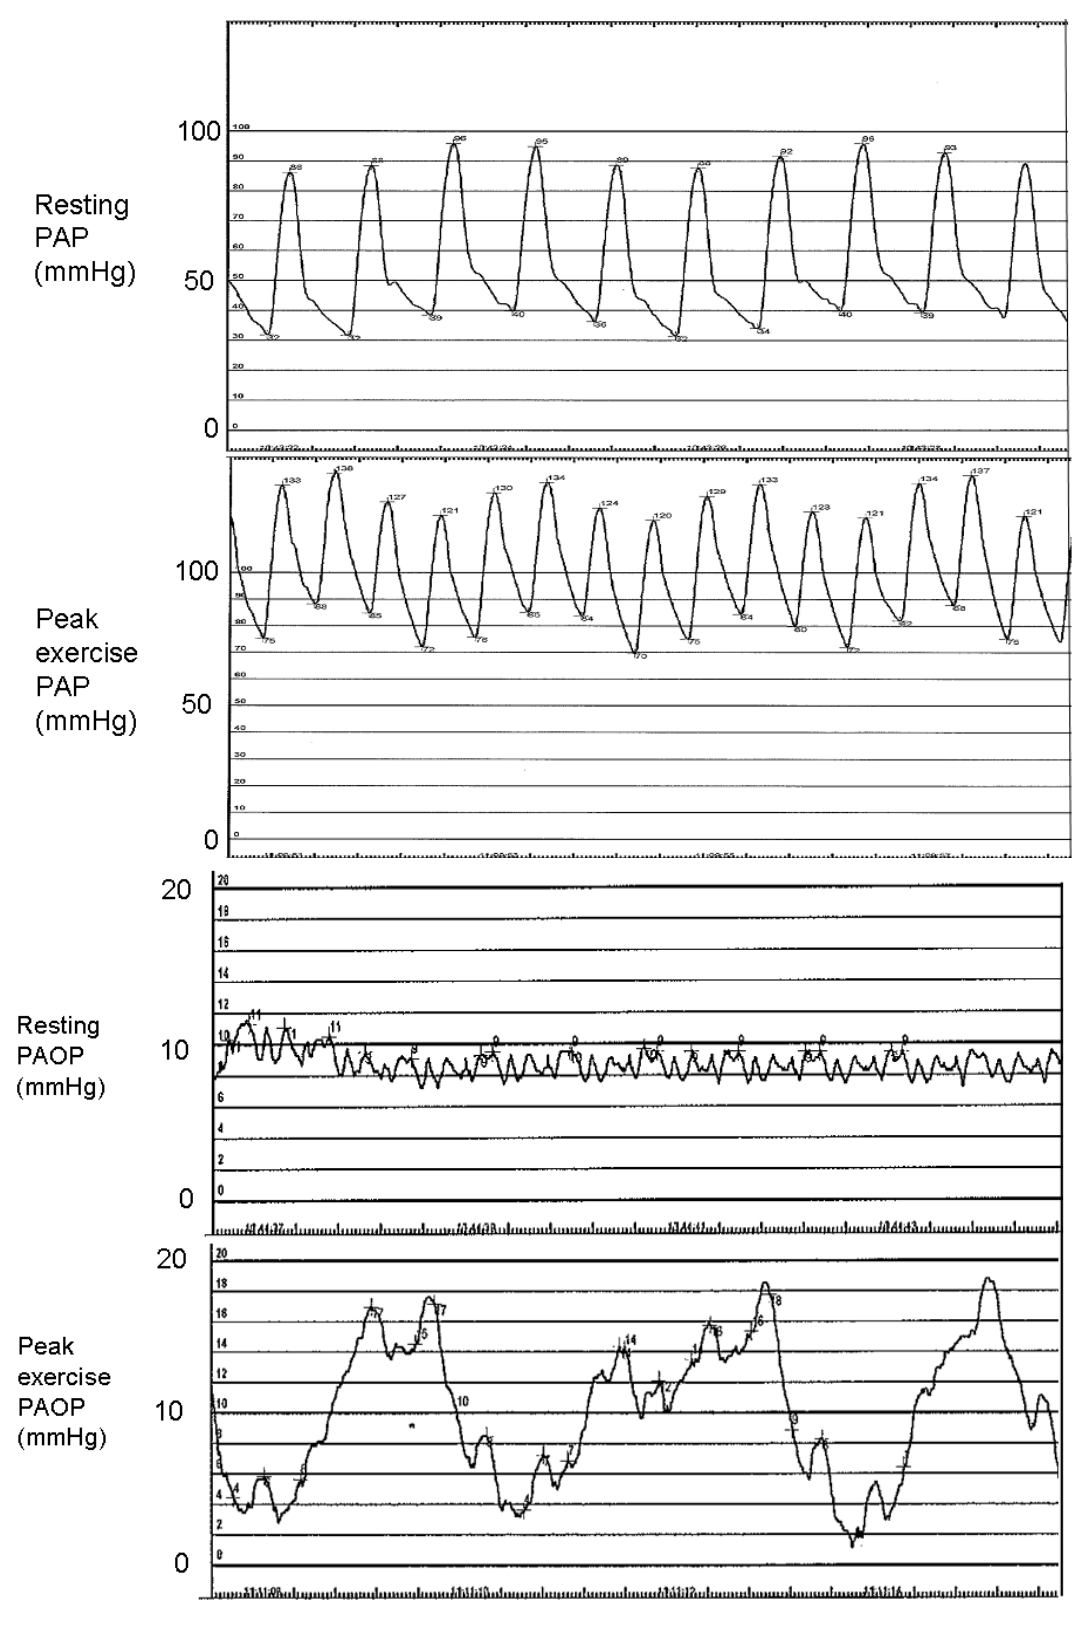
Figure 2. Right heart catheterisation traces of pulmonary artery pressure (PAP) and pulmonary artery occlusion pressure (PAOP) at rest and at peak exercise. Note both the significant elevation of PAP and the marked respiratory swing, most prominently affecting PAOP, which develops on